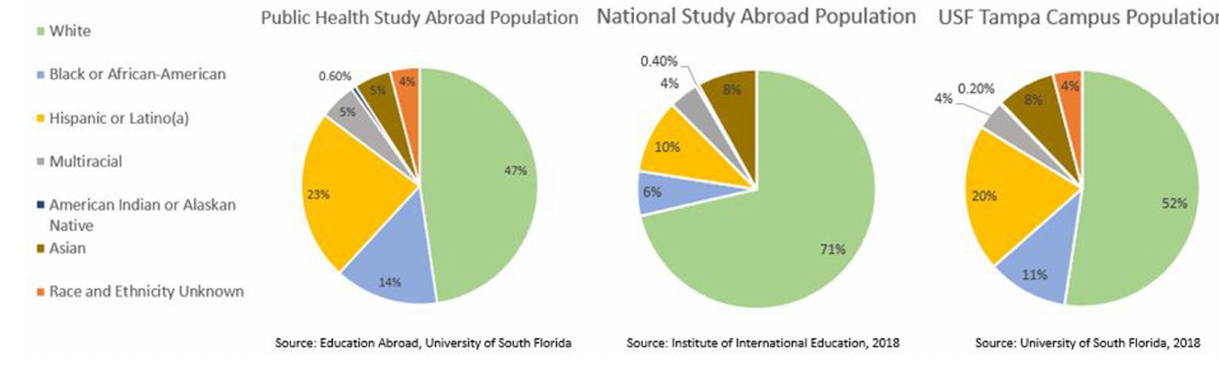
FIGURE 2 | Racial and ethnic diversity within public health focused study abroad programming at USF, the USF Tampa campus and the national study abroad